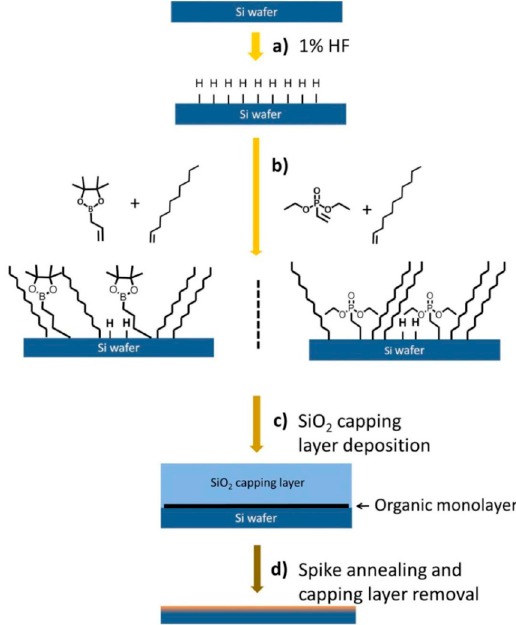
Figure 13. Schematic of the monolayer doping process [70].